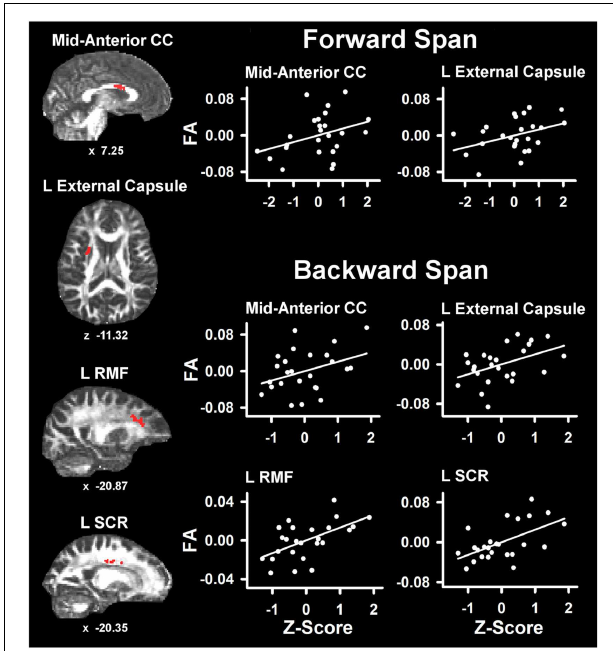
FIGURE 2 | Partial correlations between verbal working memory and fractional anisotropy (FA) in PD. Scatter plots show the relationship between Digit Span Forward and Digit Span Backward to FA in representative ROI.The values plotted for all measures are residuals from the regression of age and gender onto regional FA and cognitive performance. Cognitive measures were normalized to the control group by subtracting the individual raw scores for each measure from the control group mean and then dividing by the control group standard deviation. Higher Z scores reflect better performance.The spatial location of FA in each ROI is displayed in diffusion space for representative individual subjects. L, left hemisphere; CC, corpus callosum; RMF, rostral middle frontal; SCR, superior corona radiata. Coordinates designate distance in mm from anterior commissure: x , left ( − )/right ( + ) and z , superior ( + )/inferior ( −